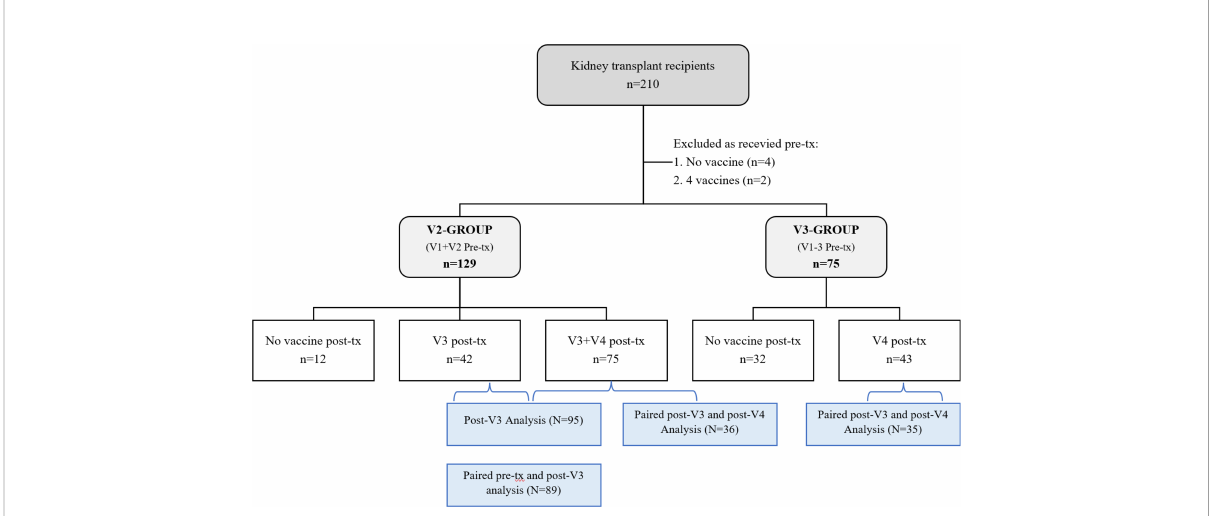
FIGURE 1 Patient cohort by vaccine status at the time of transplant 1 . 1 Samples available for analysis as